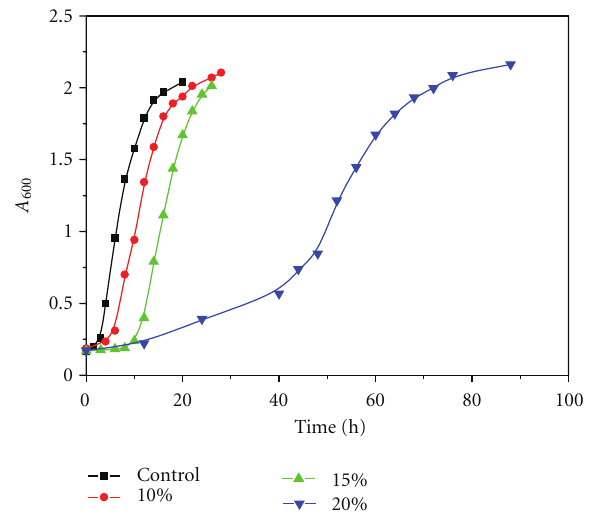
Figure 5: Growth curves of Saccharomyecs cerevisiae in a medium with varying percentage of GC (%